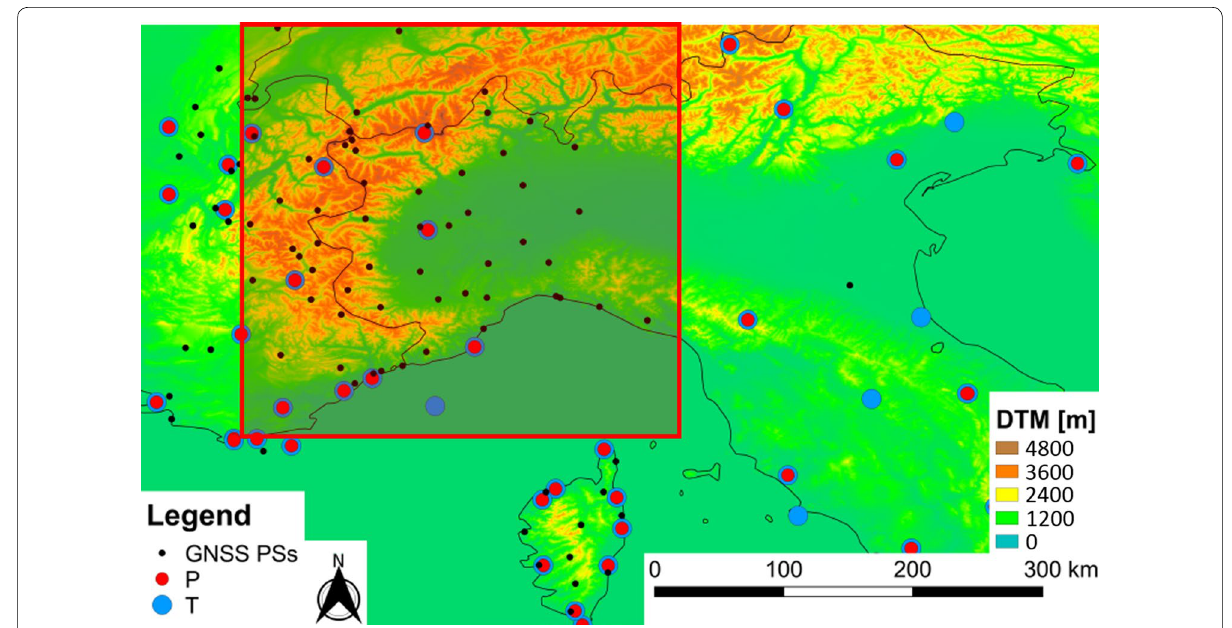
Fig. 2 Pressure ( P ) and temperature ( T ) stations of the NOAA database (red and blue dots). The black dots represent the GNSS PSs